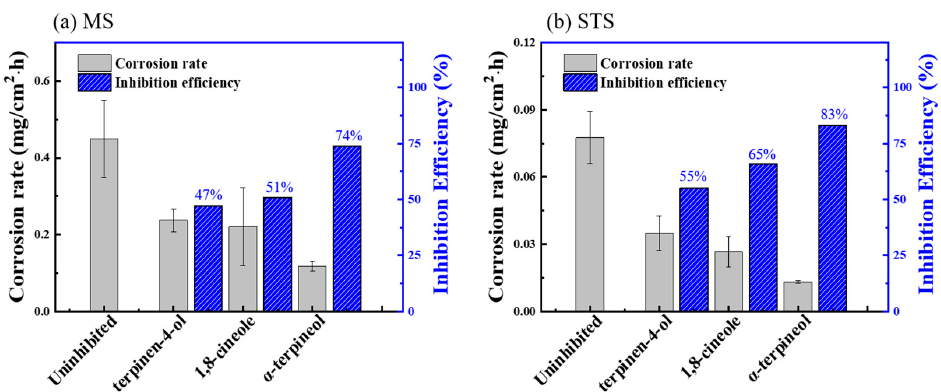
Figure 6. Corrosion rate and IE WL for ( a ) MS and ( b ) STS specimens immersed in the 1 M HCl solution at 298 K containing 0.75 g/L of constituents.